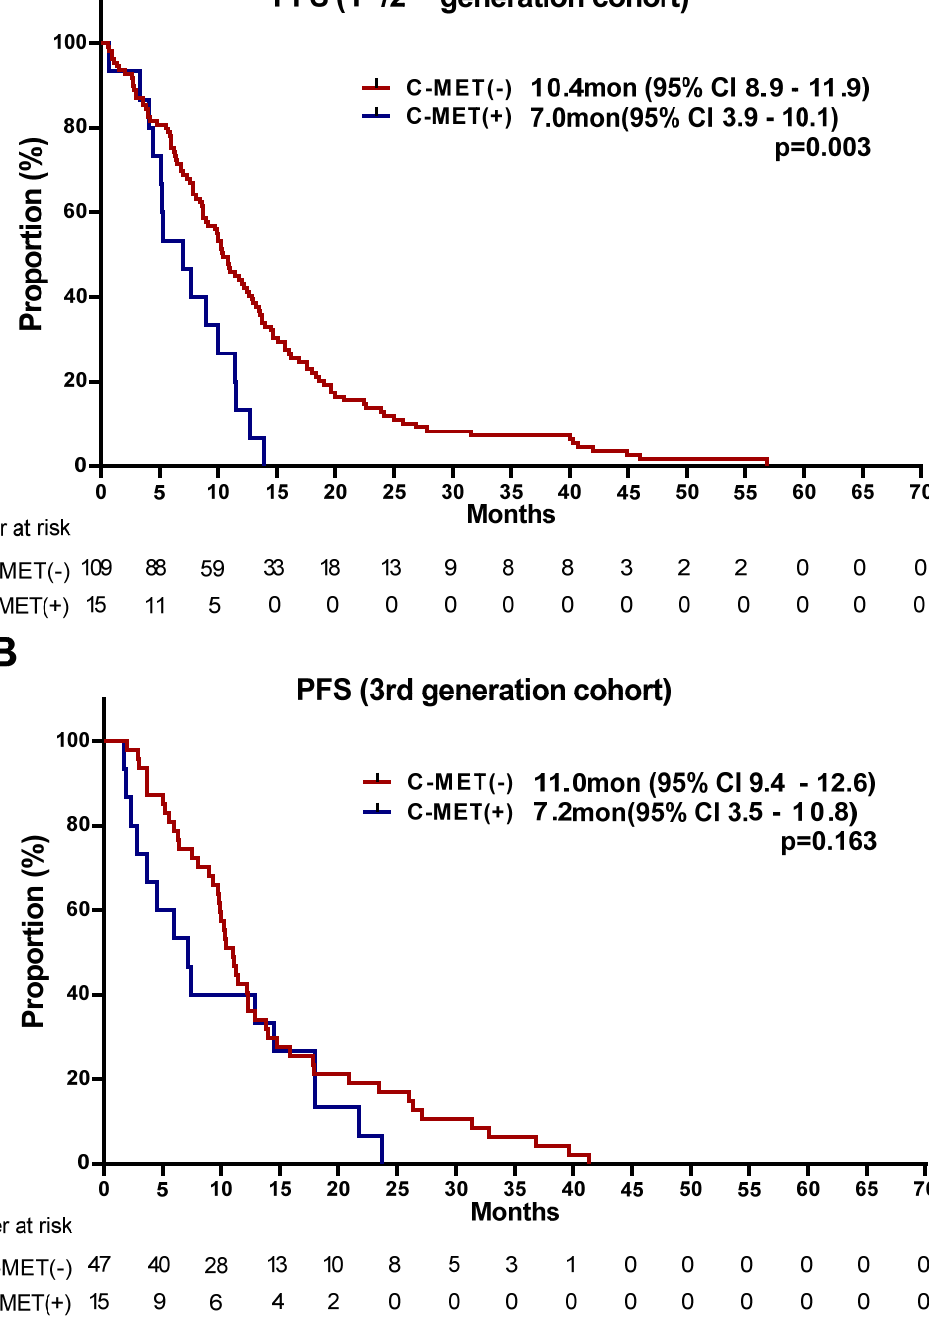
Figure 2. Kaplan-Meier plot of the progression-free survival (PFS) stratified by MET amplification status. ( A ) PFS of 1st/2nd generation tyrosine kinase inhibitor cohort. ( B ) PFS of 3rd generation tyrosine kinase inhibitor cohort. MET, mesenchymal epithelial transition factor; CI, confidence interval; mon, month.